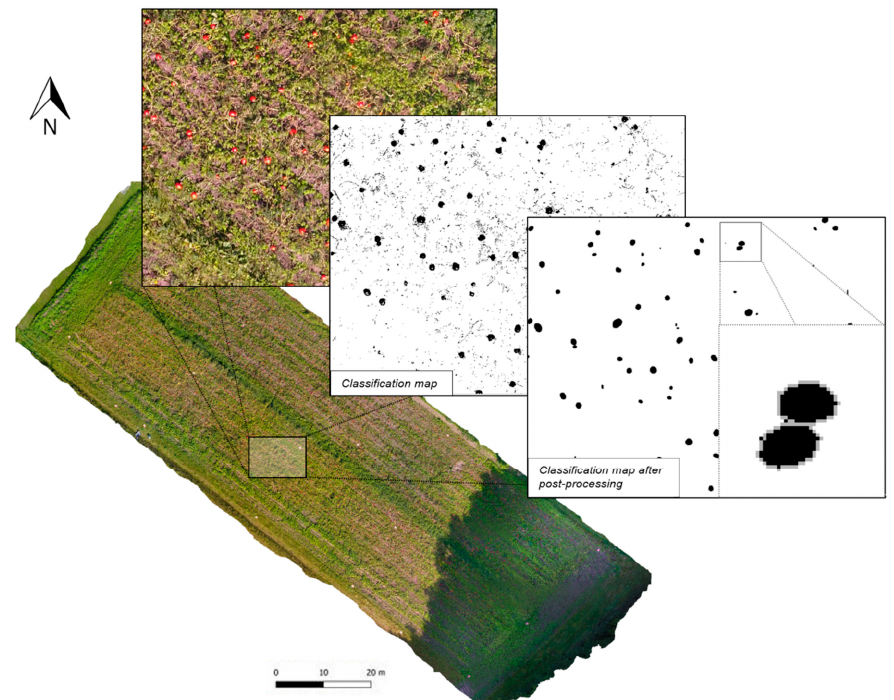
Figure 6. Orthophoto with selected classification steps during fruit detection